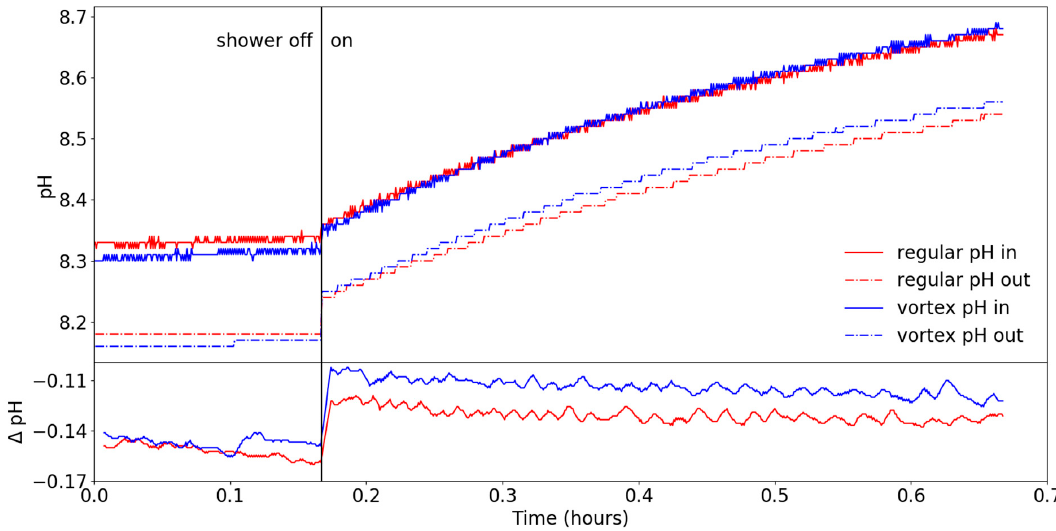
Figure 9. pH against time for both showerheads before (full) and after (dot-dashed) the spray in a circulating water setup at 35.8 °C. The lower part is the difference between the two pH sensors for both showerheads, shown as a moving average over 3 minutes.